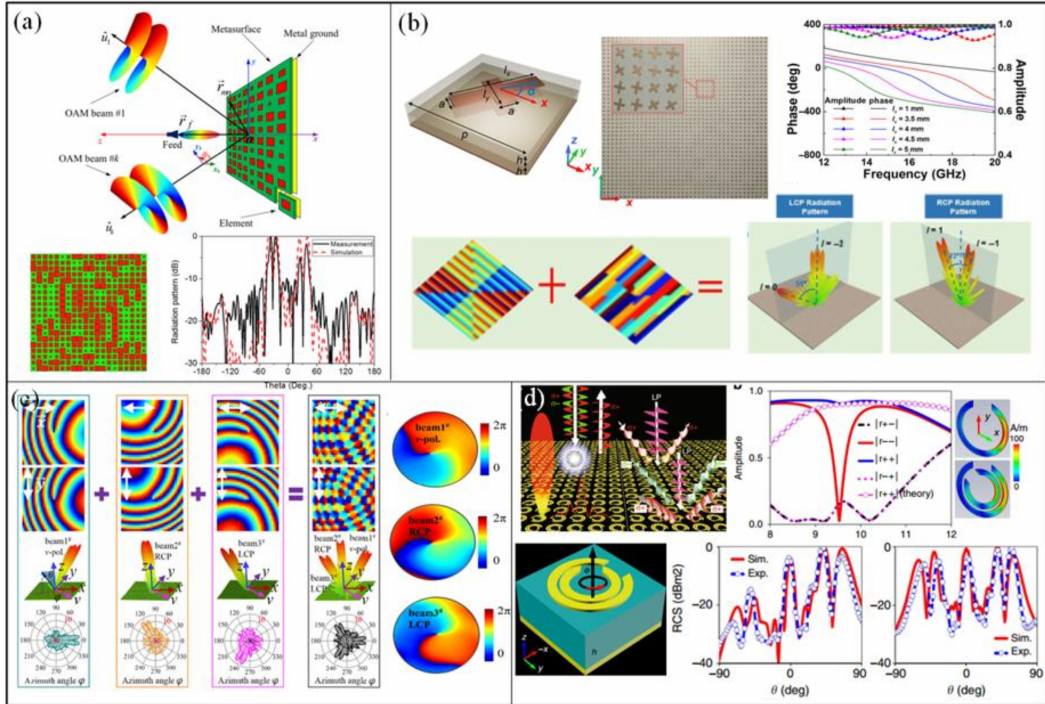
Figure 11. Multiplexed OAM reflective metasurfaces. ( a ) Single linear polarization reflective metasurface to generate multiple vortex beams [65]. ( b ) Circular polarized (CP) wave decoupling to achieve multiplexed vortex beams [66]. ( c ) Full polarization multi-beams [67]. ( d ) A decoupling method to generate dual CP vortex beams at di ff erent frequencies